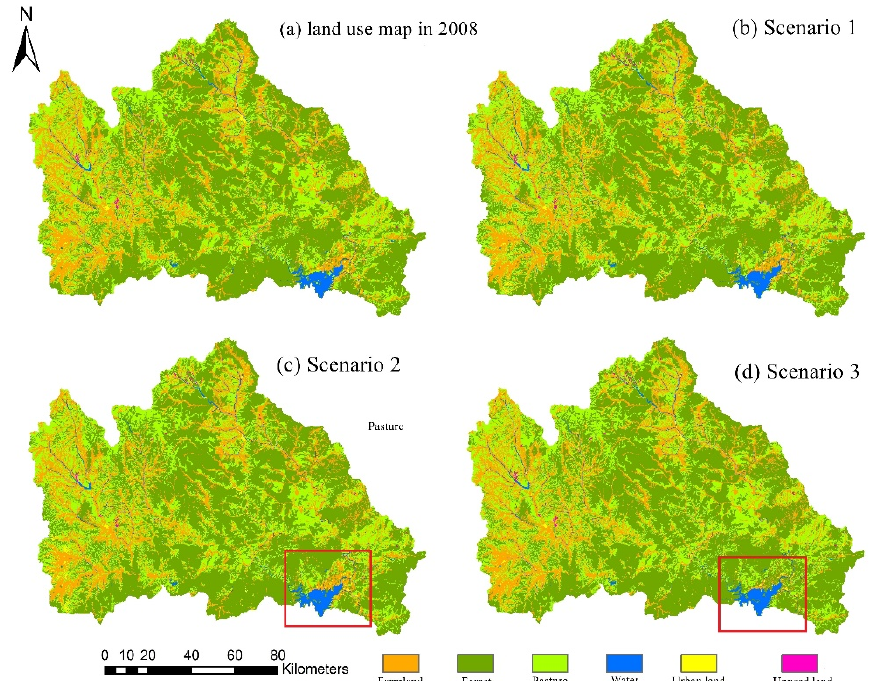
Figure 14. Simulation results for land use under different scenarios in the watershed in 2042. ( a ) land use map in 2008; ( b ) historical trend scenario; ( c ) ecological protection without consideration of spatial configuration scenario; ( d ) ecological protection scenario with more forest.